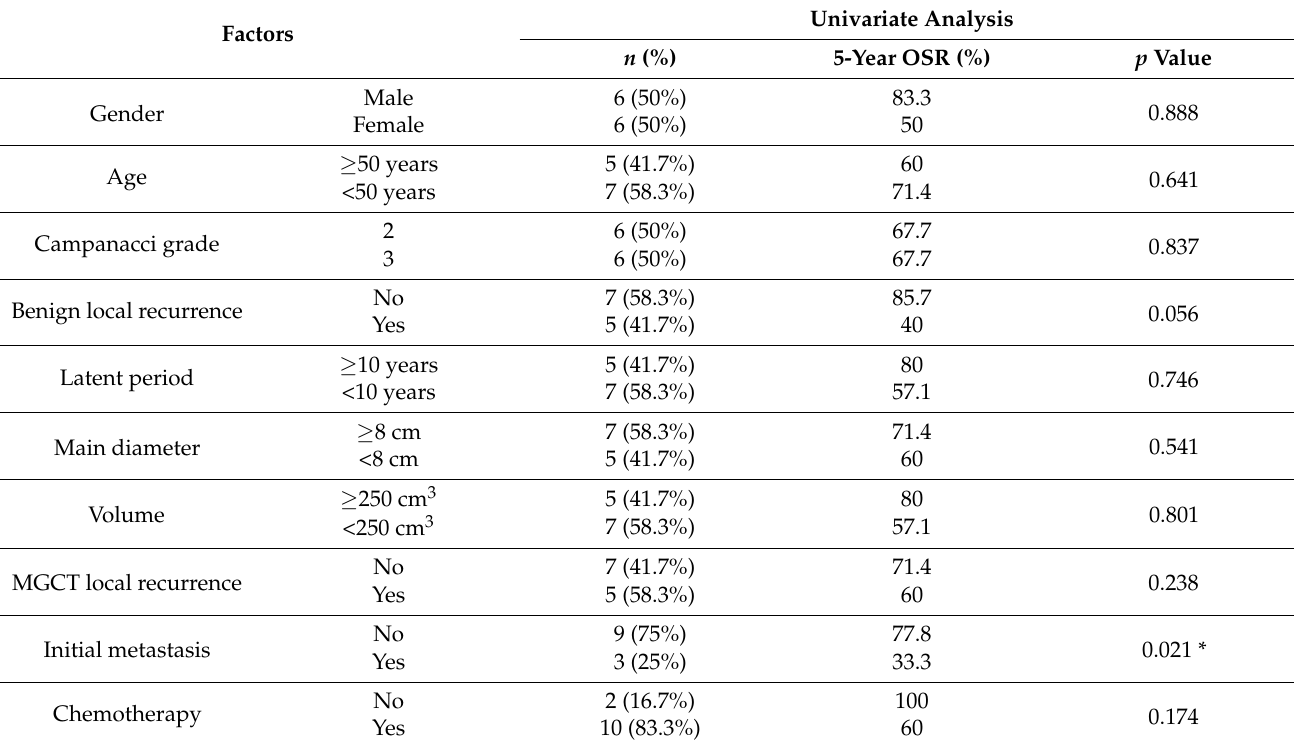
Table 3. Statistical analysis of prognostic factors for overall survival.